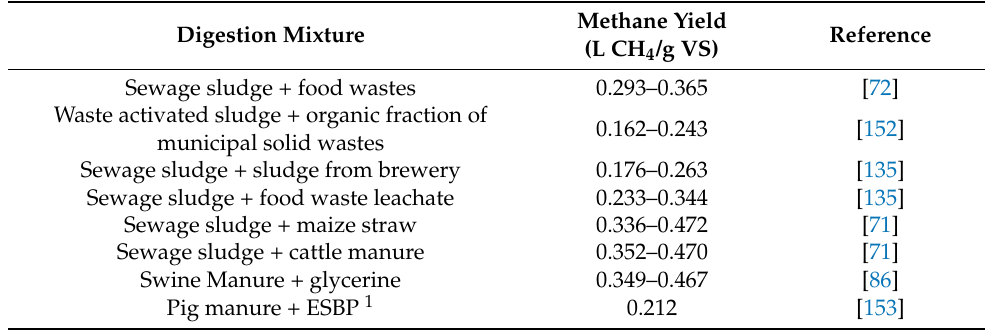
Table 4. Methane yields found in the literature for different co-digestion mixtures obtained from batch